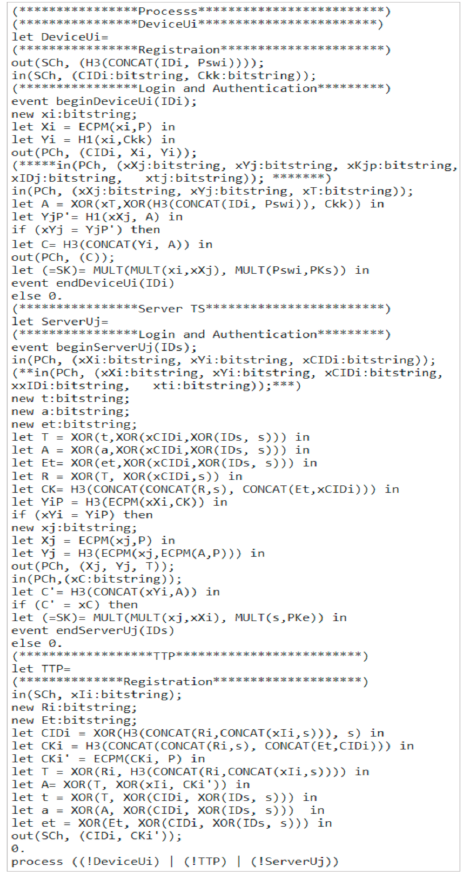
Figure 9. Process specification for embedded device and server.